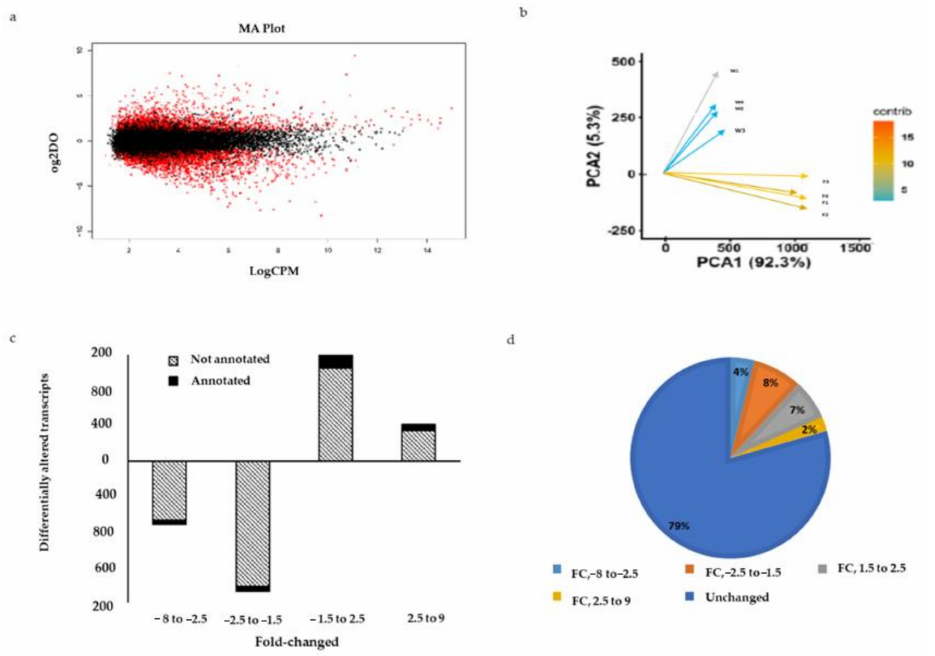
Figure 5. Transcriptomic comparisons between wild and farmed sea cucumbers. ( a ) MA plots of differentially expressed genes (DEGs) between wild and farmed sea cucumbers. Red dots show transcripts with a false discovery rate (FDR) < 0.05. ( b ) PCA and variable contribution to the transcriptomic data. ( c ) Differentially altered transcripts. ( d ) Percentage of altered